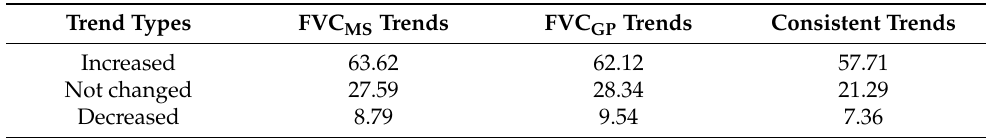
Figure 4. Spatial distribution of trends in the FVC MS (May–September) of grasslands during 2000–2019. Table 4. Comparison of composition (%) of FVC MS and FVC GP trends based on MOD13Q1 C6 data in the TP during 2000–2019.